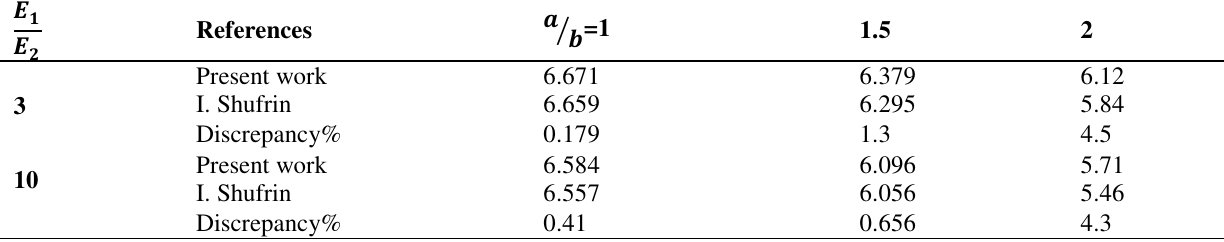
Non-dimensional buckling load modulus ratio, (